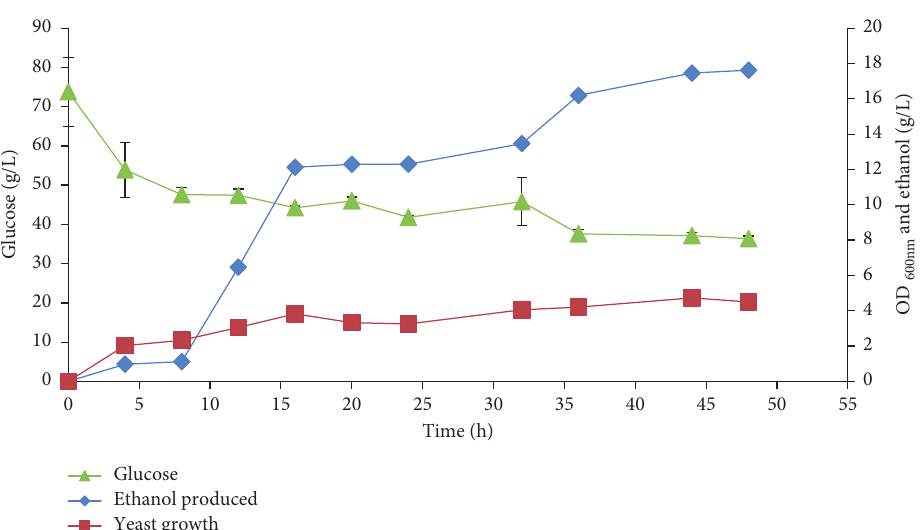
Figure 5: Time course of the separate hydrolysis and fermentation of the alkaline pretreated BPS saccharified with T. longibrachiatum LMLSAUL 14-1